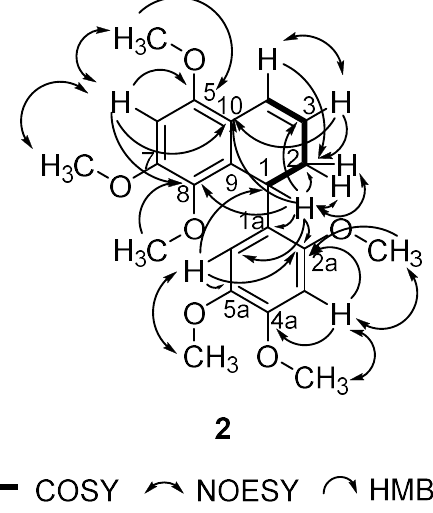
Figure 2. Key COSY, NOESY, and HMBC Correlations of Pachypostaudin B ( 2 ).